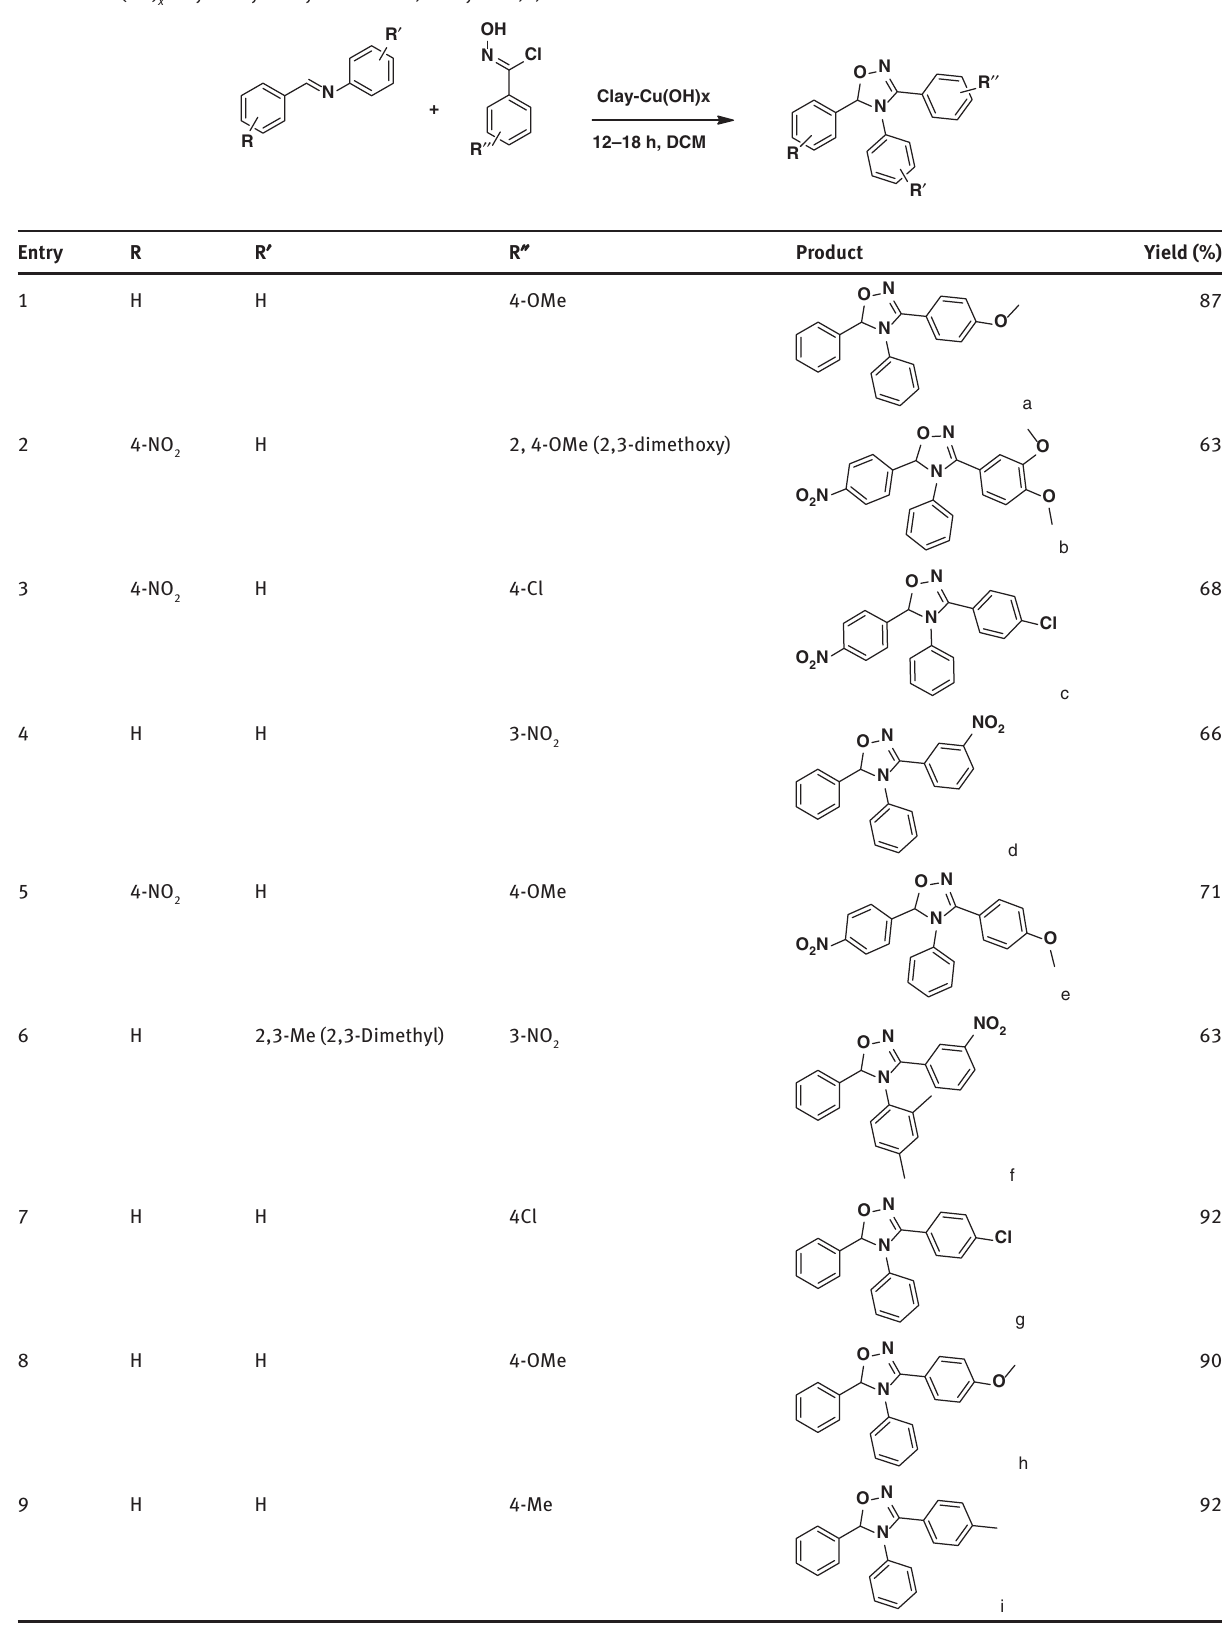
-clay catalyzed synthesis of 4,5-dihydro-1,2,4-oxadiazoles. a x